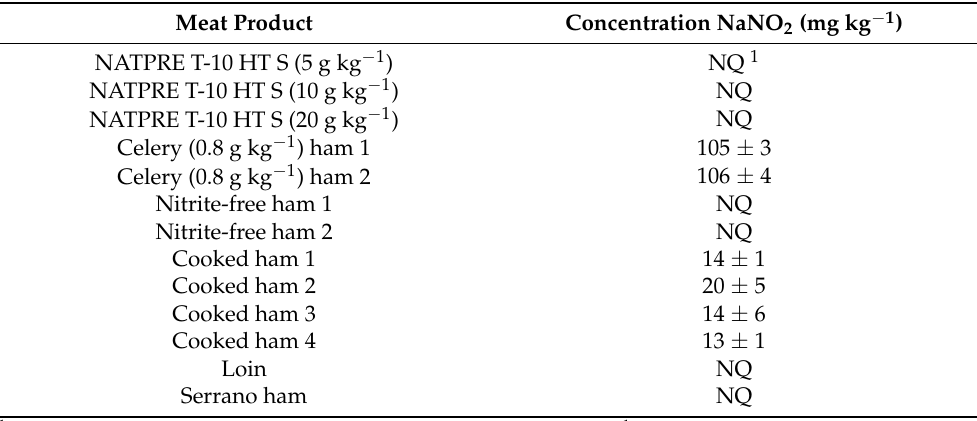
Table 4. Sodium nitrite content in meat products determined by